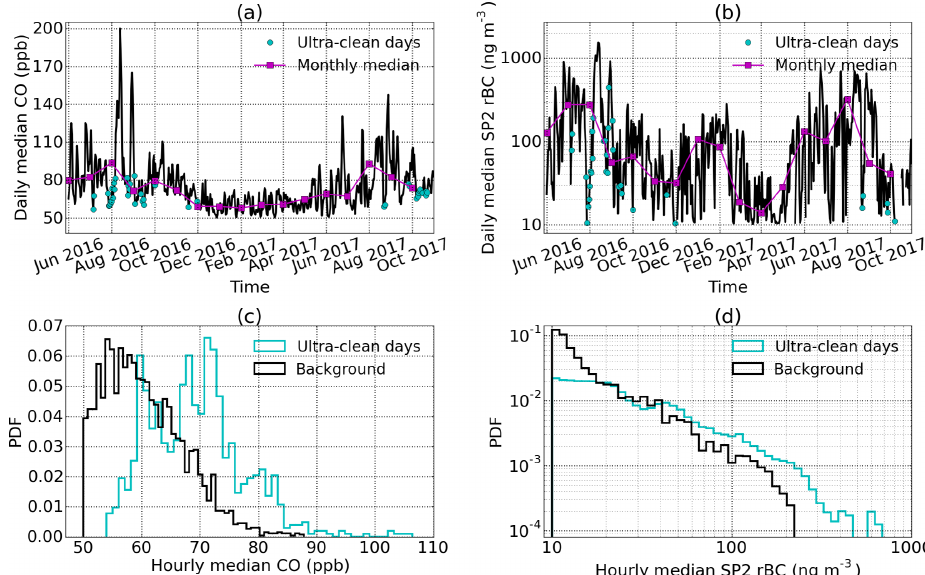
Figure 2. Time series of daily and monthly median (a) CO and (b) rBC measured during LASIC, with ultra-clean days marked in cyan. In panels (a) and (b) , vertical grid lines mark the first of each month labeled on the tick. We then compare the PDF of hourly median (c) CO and (d) rBC from ultra-clean days to the PDF of hourly median concentrations from each tracer’s respective non-burning background.